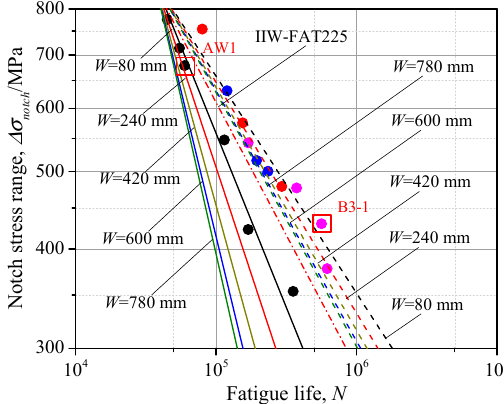
Figure 15. The S - N curve considering main plate width W.